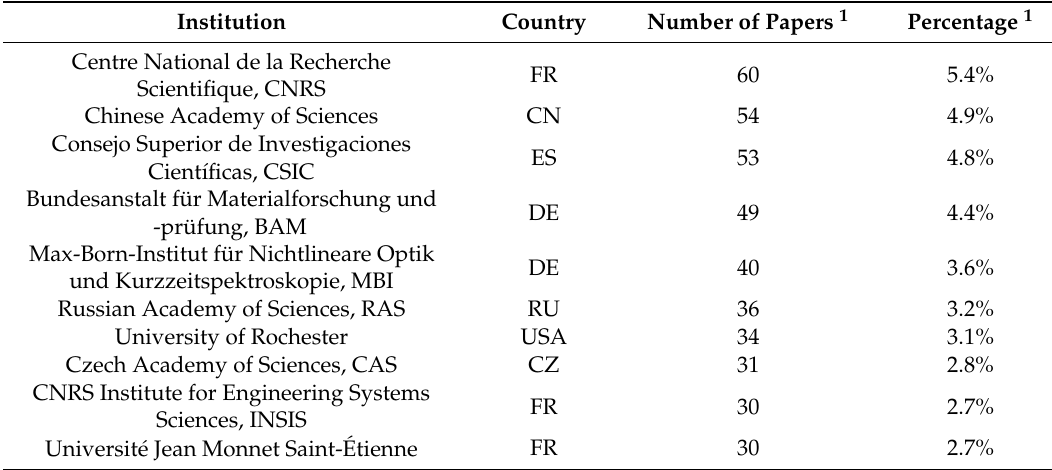
Table 1. Top 10 international research institutions with publications associated to the scientific topic of LIPSS, evaluated on basis of the “ISI Web of Science” database 1